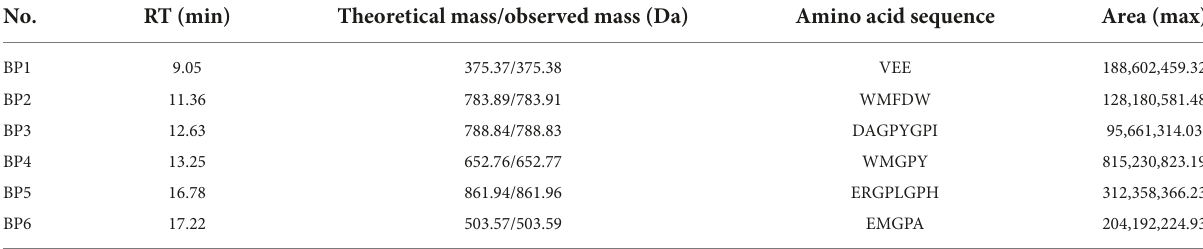
TABLE 1 Retention time (RT), molecular mass (Da), and amino acid sequences of six isolated bioactive peptides (BPs) (BP1 to BP6) from the CEST. Theoretical mass/observed mass